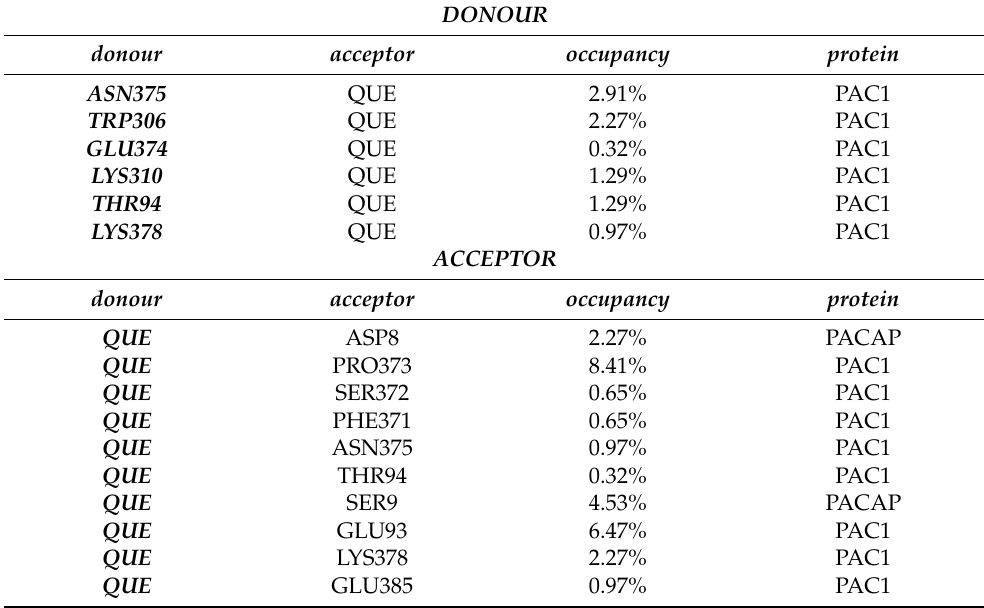
Table A2. H-bond values for the interaction between quercetin (QUE) and the conjugated